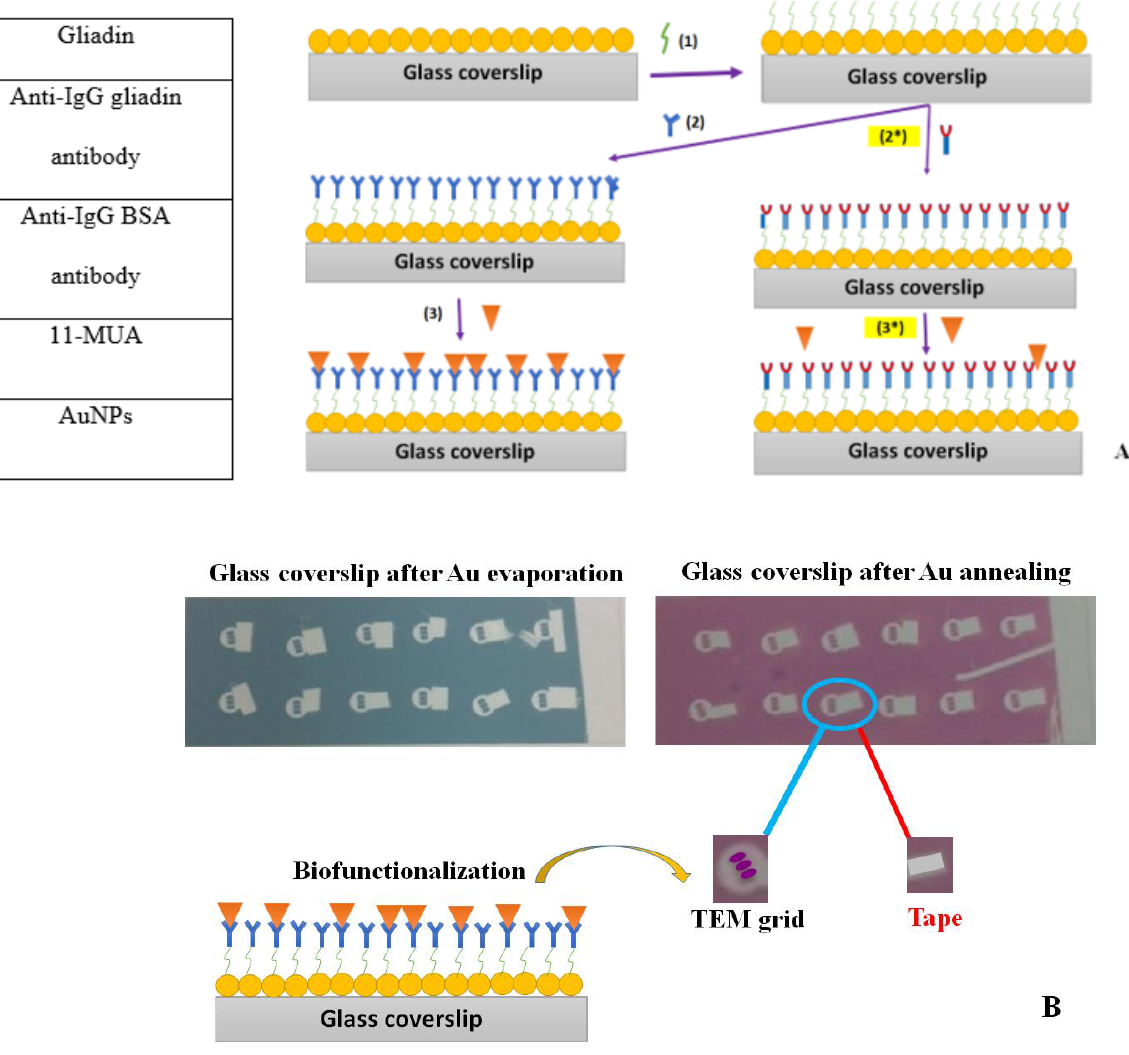
Figure 1. Preparation of the gliadin immunosensor on annealed gold nanostructured glass coverslip: (1) thiol 11-MUA; (2) immobilization of anti-IgG gliadin antibodies; (2*) specific immune-recognition of gliadin molecules; (3) immobilization of anti-IgG BSA antibodies, (3*) non-specific immune-recognition of gliadin molecules ( A ) and photos of glass coverslip after Au evaporation and annealing at 550 °C for 3 h on a hot plate ( B ).